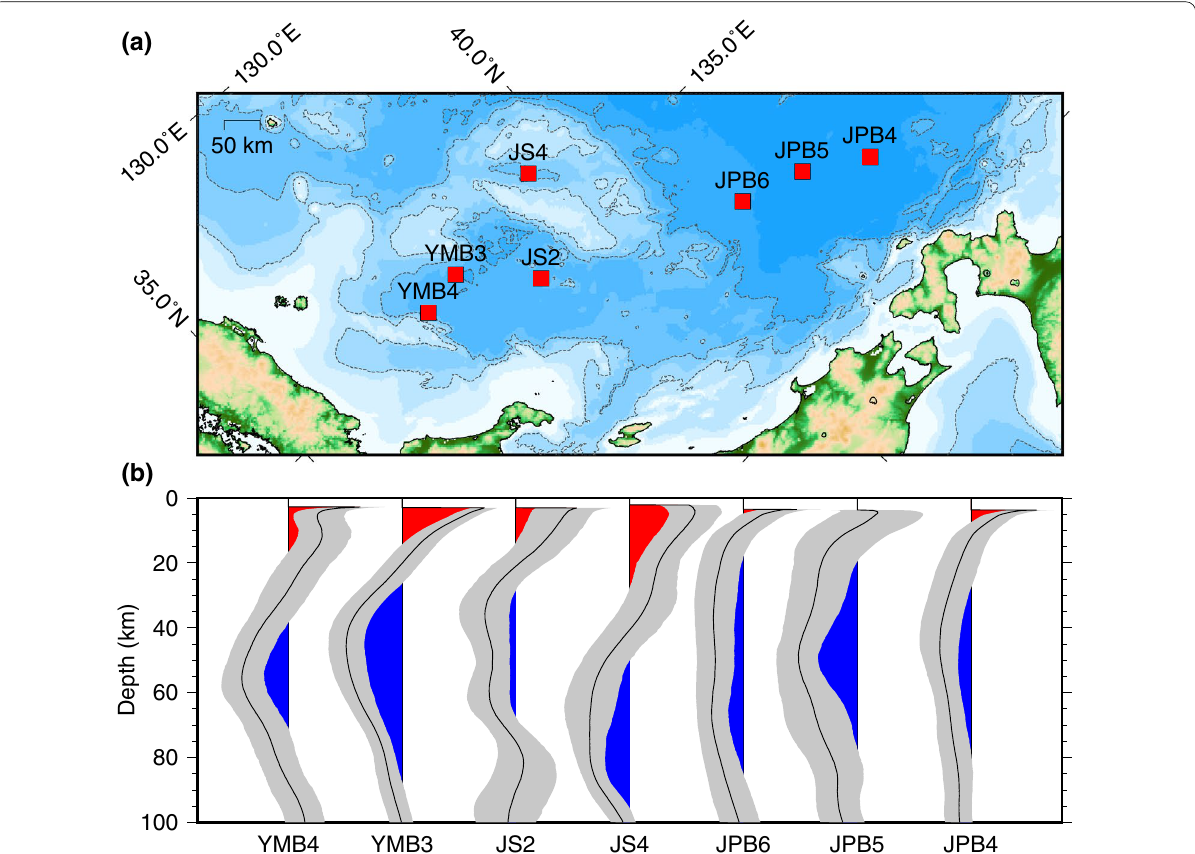
Fig. 10 Time-to-depth-converted and stacked S-receiver functions (S-RFs) for each station. a Stations locations (red squares). b The depth-converted, stacked S-RFs. Positive and negative amplitudes are shaded in red and blue, respectively. The gray shade represents the 95% confidence interval from bootstrap resampling 1000